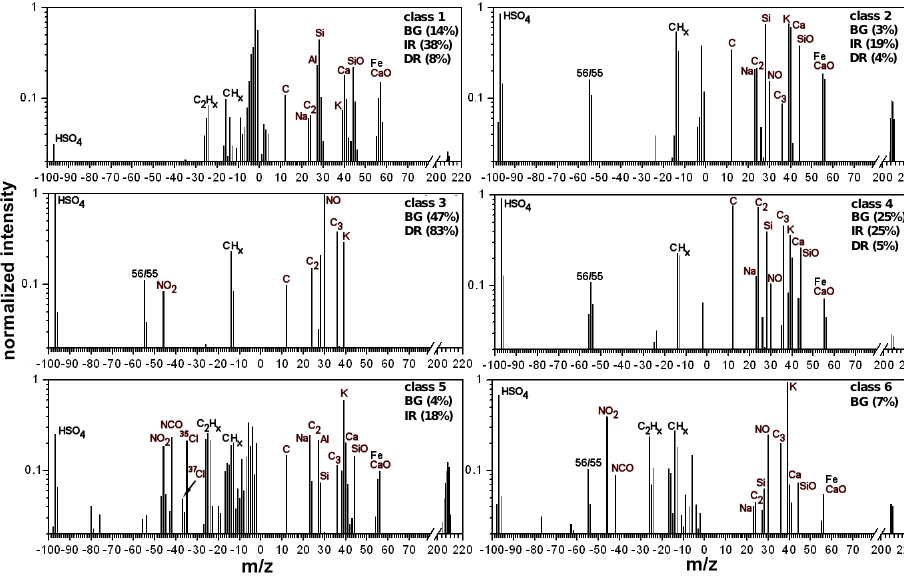
Fig. 3. Cluster centers from the classification of background aerosol particles (BG), ice residues (IR) and droplet residues (DR). For each class only one example from the background aerosol particles or the ice residue SPLAT measurements is